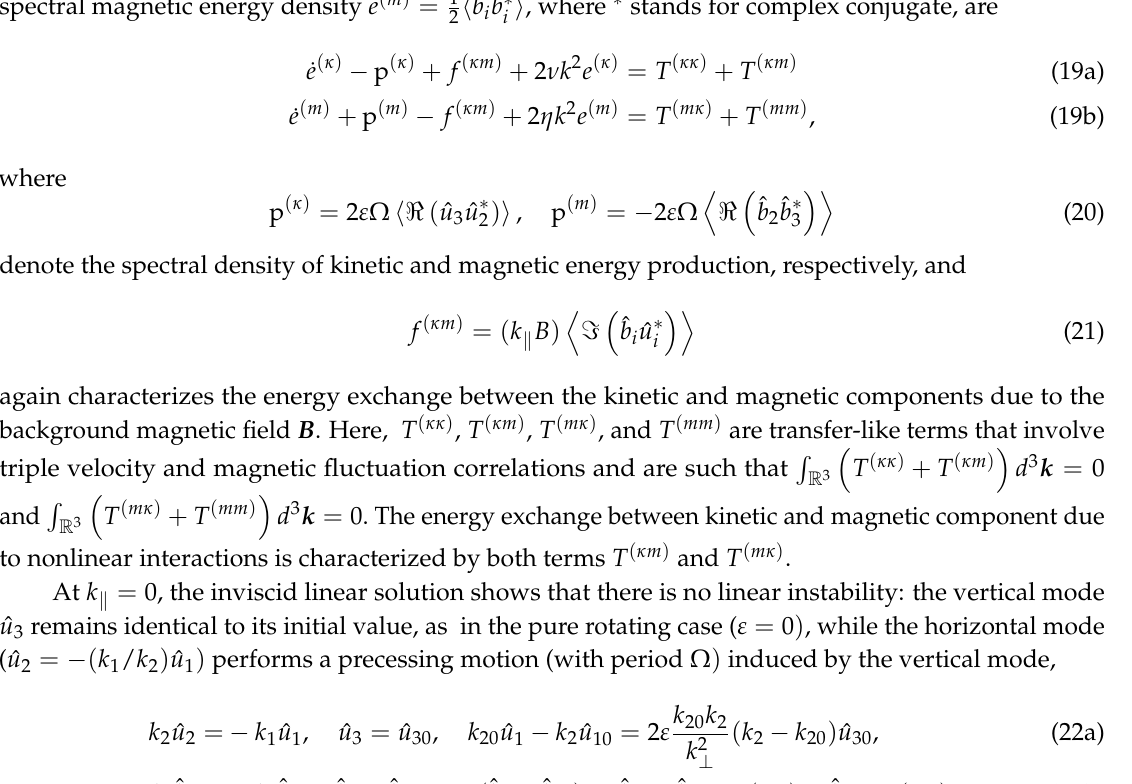
(cid:113) (cid:112) (cid:12) (cid:12) 1 − γ 2 / ( 4 γ 1 + 4 L 2 Ω ) where γ = (cid:12) 1 − γ − 2 γ 2 (cid:12) (cid:113) 3 + 16 L 2 Ω / [ 8 ( 1 + 4 L 2 Ω ) 2 ] . Magnetic